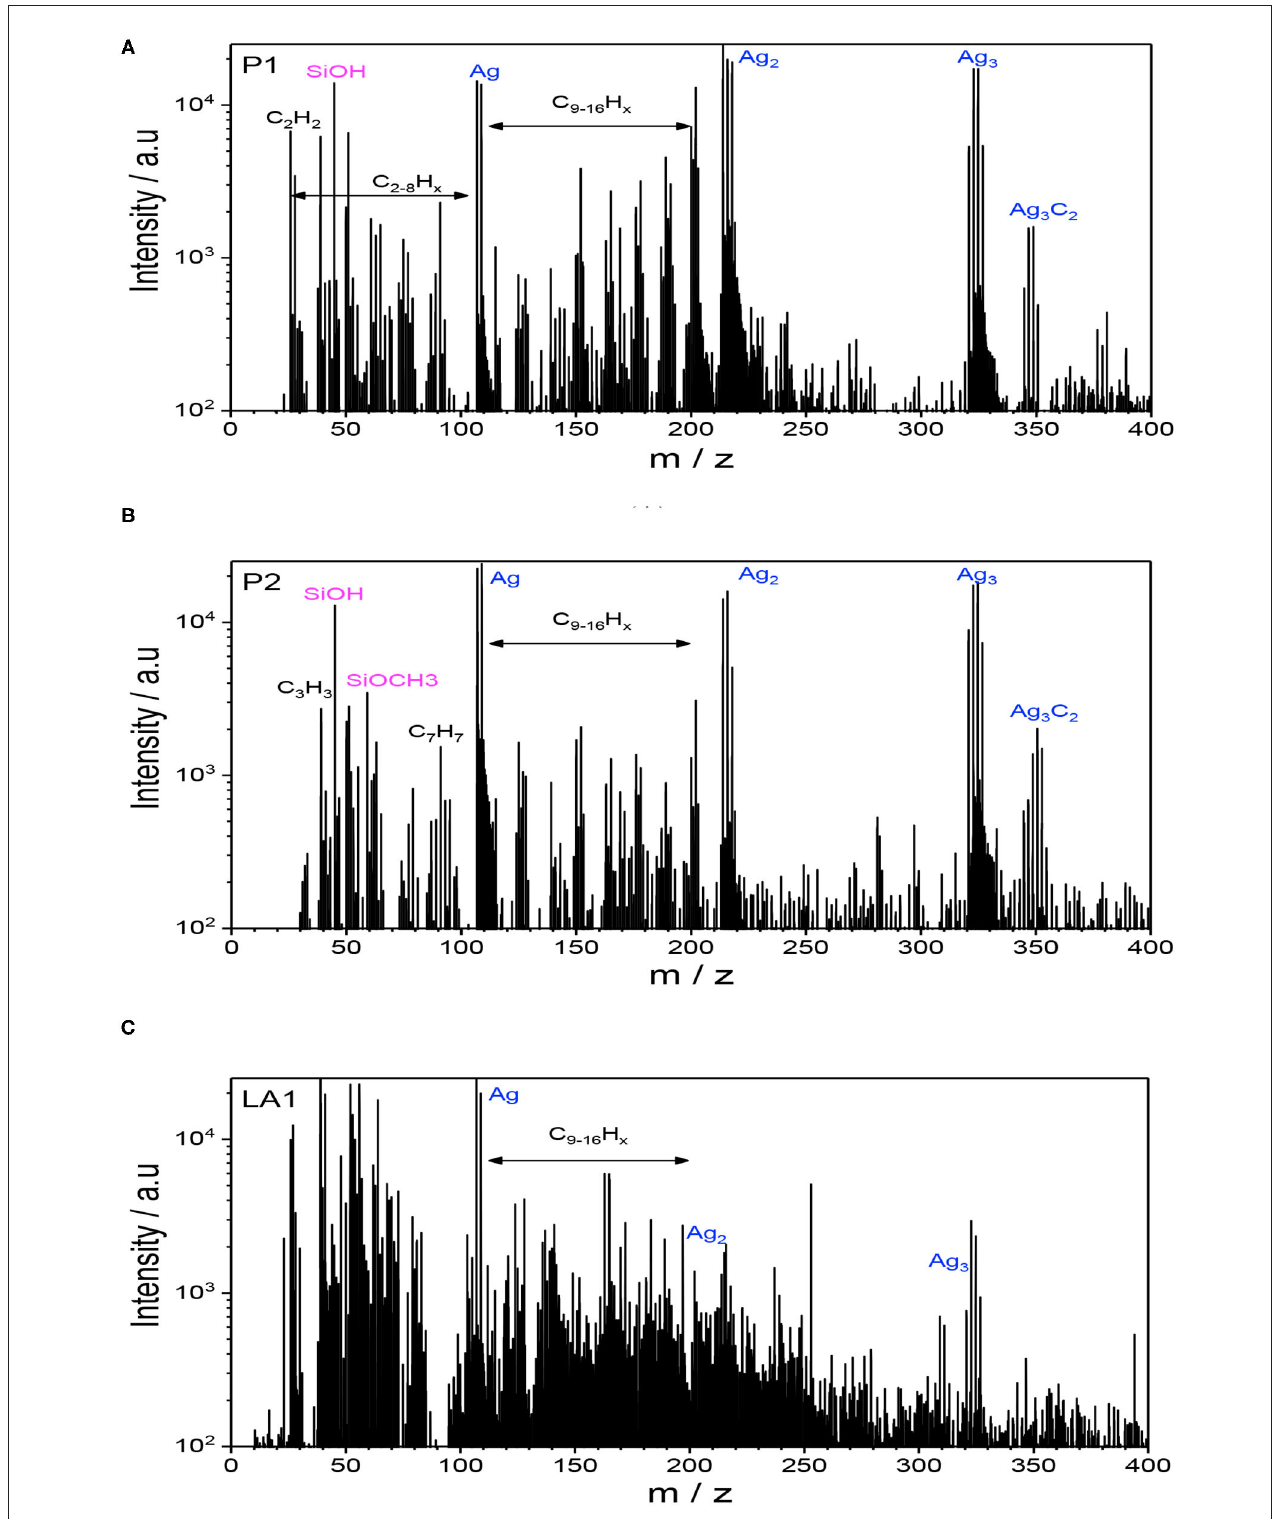
FIGURE 4 | Mass spectra obtained with the AROMA setup for samples P1 (A) , P2 (B) , and LA1 (C) compiled in Table 1 .